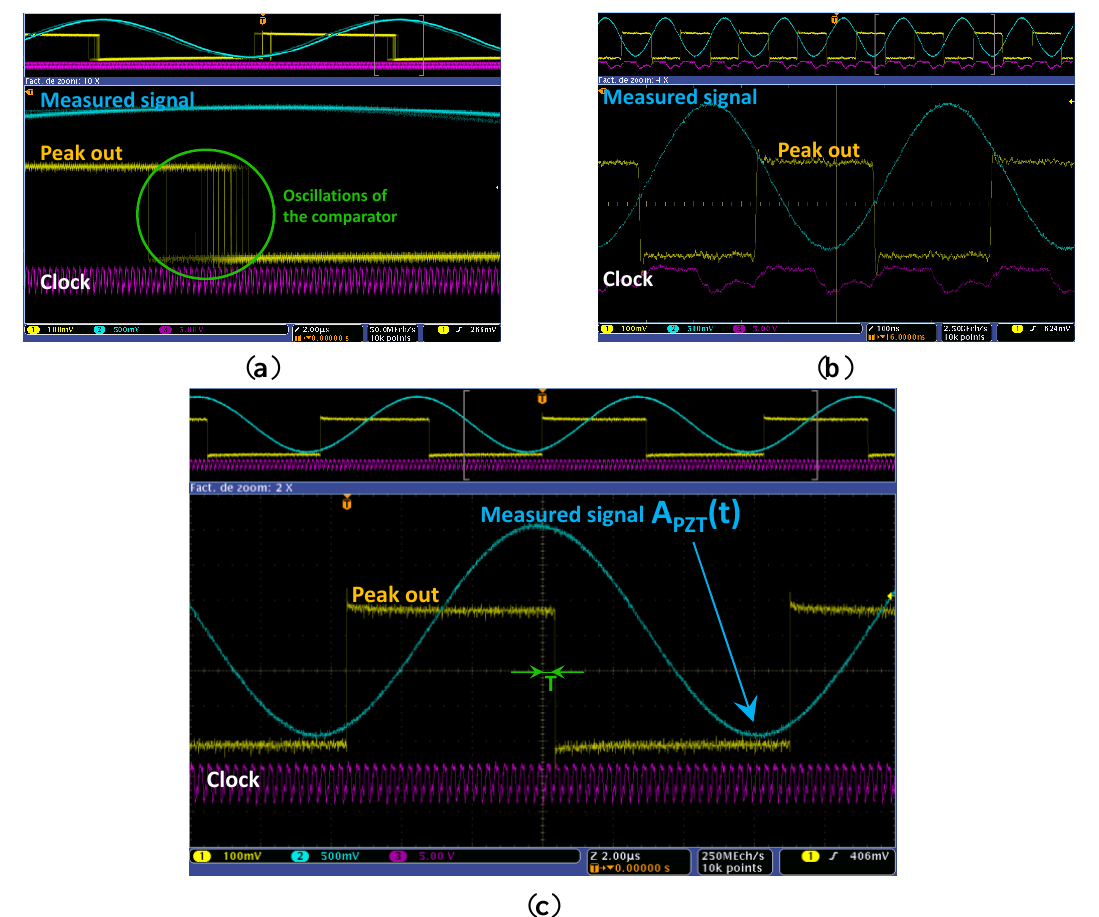
Figure 14. Experimental results acquired using an oscilloscope for the implemented peak detector. Notice that the clock is fixed to 4MHz for the three experimentations. ( a ) The frequency of the injected signal is too slow (8 kHz) for the used clock. Notice the oscillations of the comparator. ( b ) The injected signal is too fast. Notice that its frequency (2 MHz) is half the used clock frequency. The detection is totally erroneous. ( c ) Correct detection due to a ratio of 50 between the injected signal and the master